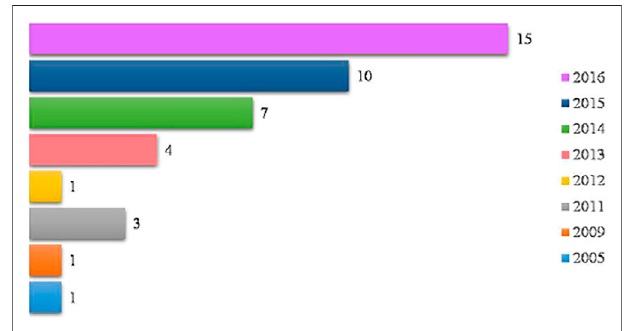
FIGURE 4 | Number of primary studies by year.